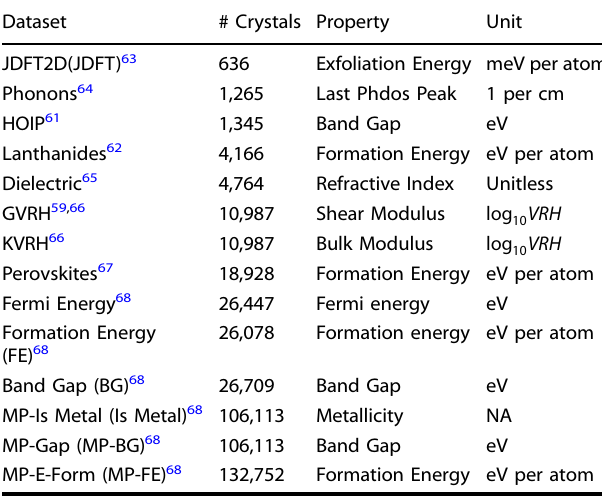
Table 1. Overview of the datasets used for benchmarking the performance of the CT framework.